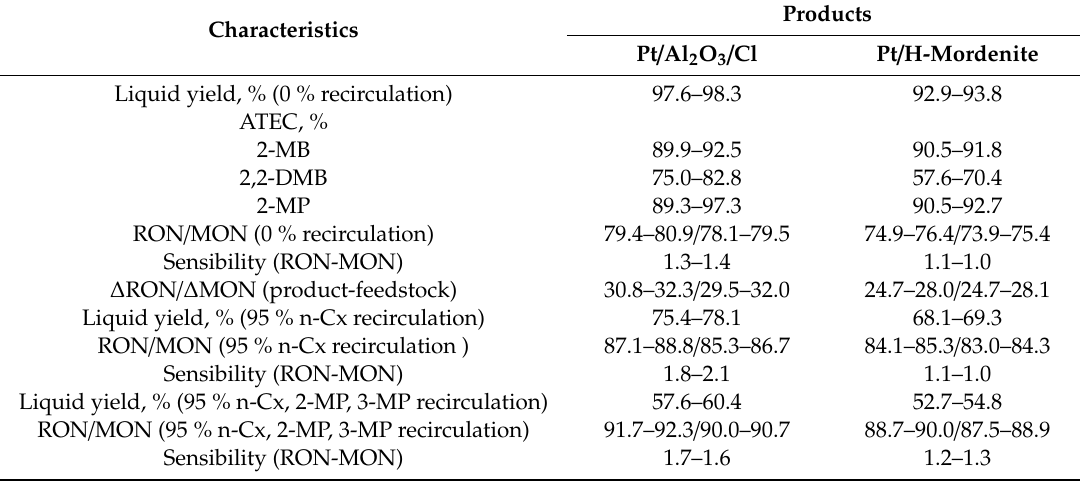
Table 6. Main characteristics of liquid products obtained over Pt / Al 2 O 3 / Cl and Pt / H-Mordenite catalysts at favorable process parameters (respectively: temperature, 125–135 ◦ C; LHSV, 1.0–1.33 h − 1 ; and temperature, 260 ◦ C; LHSV, 1.0–1.5 h − 1